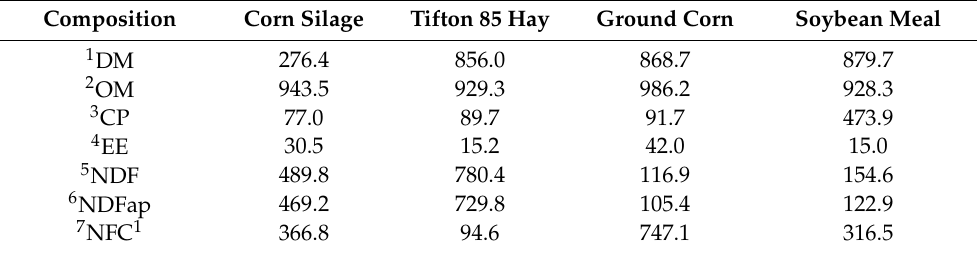
Table 1. Dietary ingredients chemical composition (dry matter (DM), g / kg). Composition